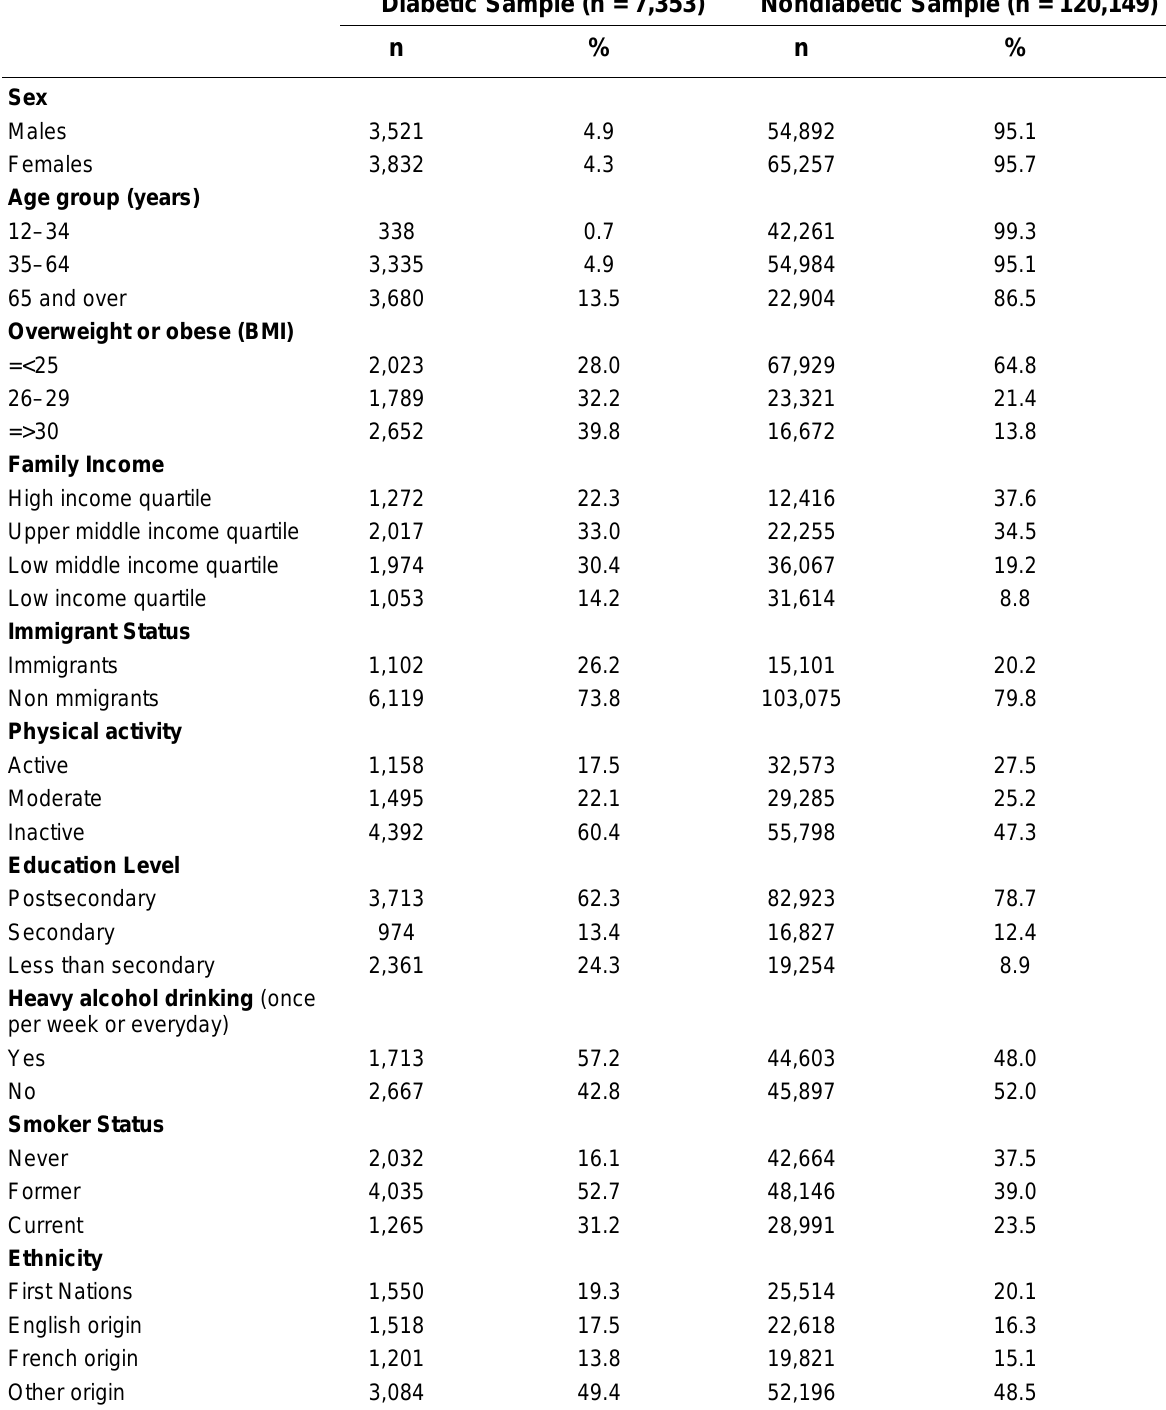
Distribution of Personal, Risk Factors, and Socioeconomic Characteristics by Diabetic Status Among Canadians 12 Years of Age and Over (CCHS, Canada,